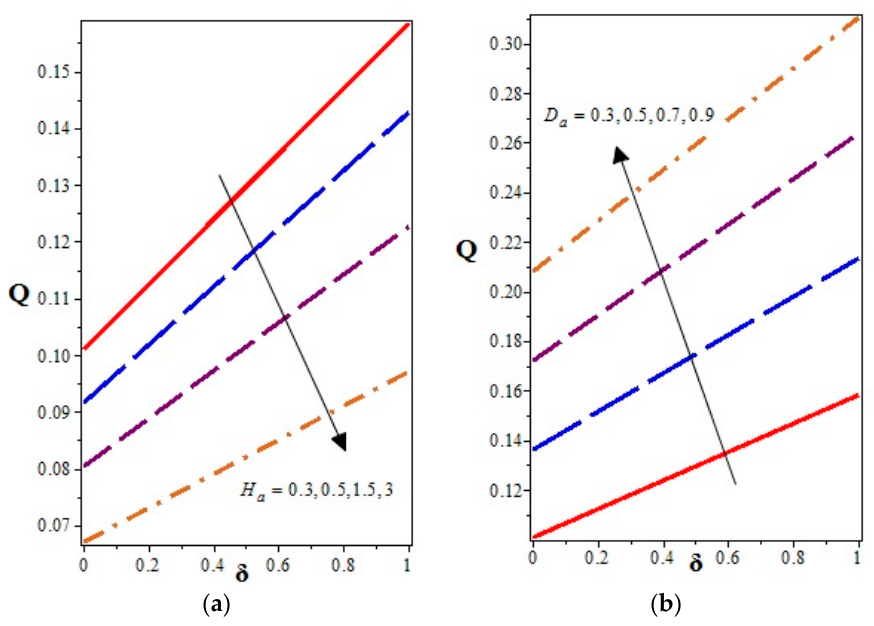
( a ) ( b ) δ H , ( b ) D , keeping other Figure 7. Volume flow rate Q versus for different values of ( a ) Figure 7. Volume flow rate Q versus δ for di ff erent values of ( a ) H a , ( b ) D a , keeping other parameters a a fixed as λ 1 = 1.5, g t = 0.5, S t = 0.5, g c = 0.5, S r = 0.5, S c = 0.1, β = 0.4, and ε = parameters fixed as 1